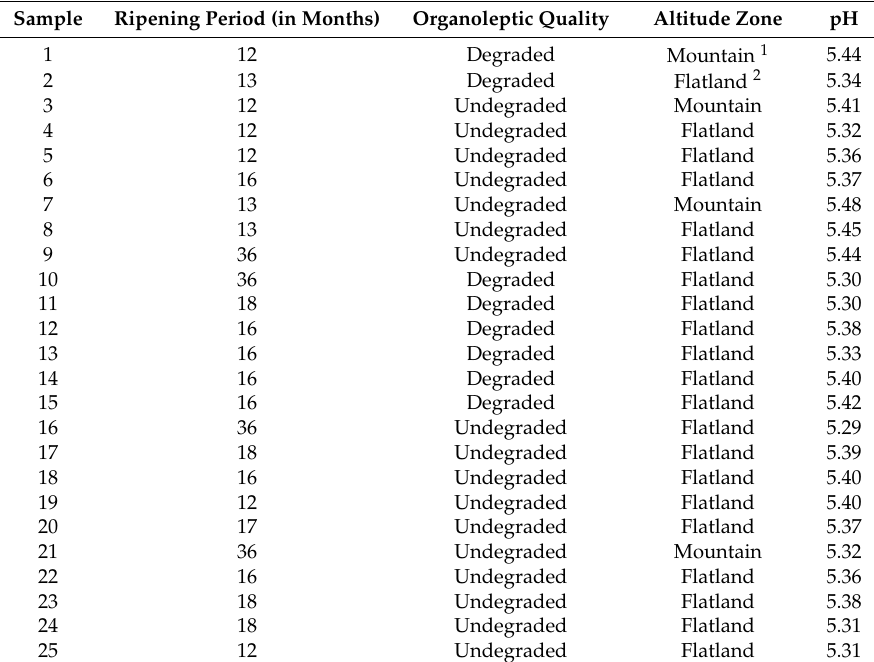
Table 1. Characteristics of the analyzed cheese samples within the present